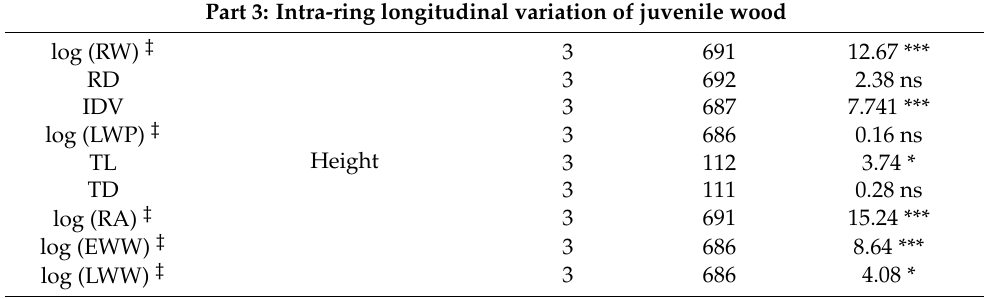
Table 2. Cont. Part 3: Intra-ring longitudinal variation of juvenile